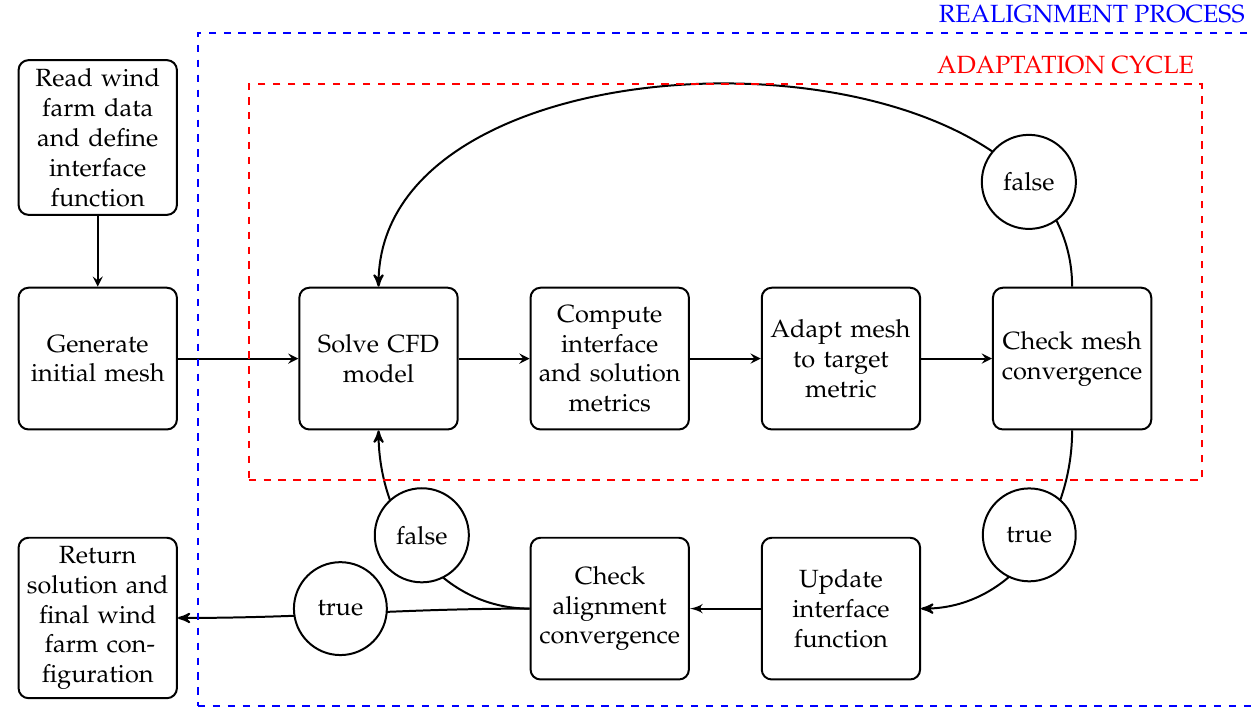
Figure 2. Simulation framework: adaptation cycle and realignment